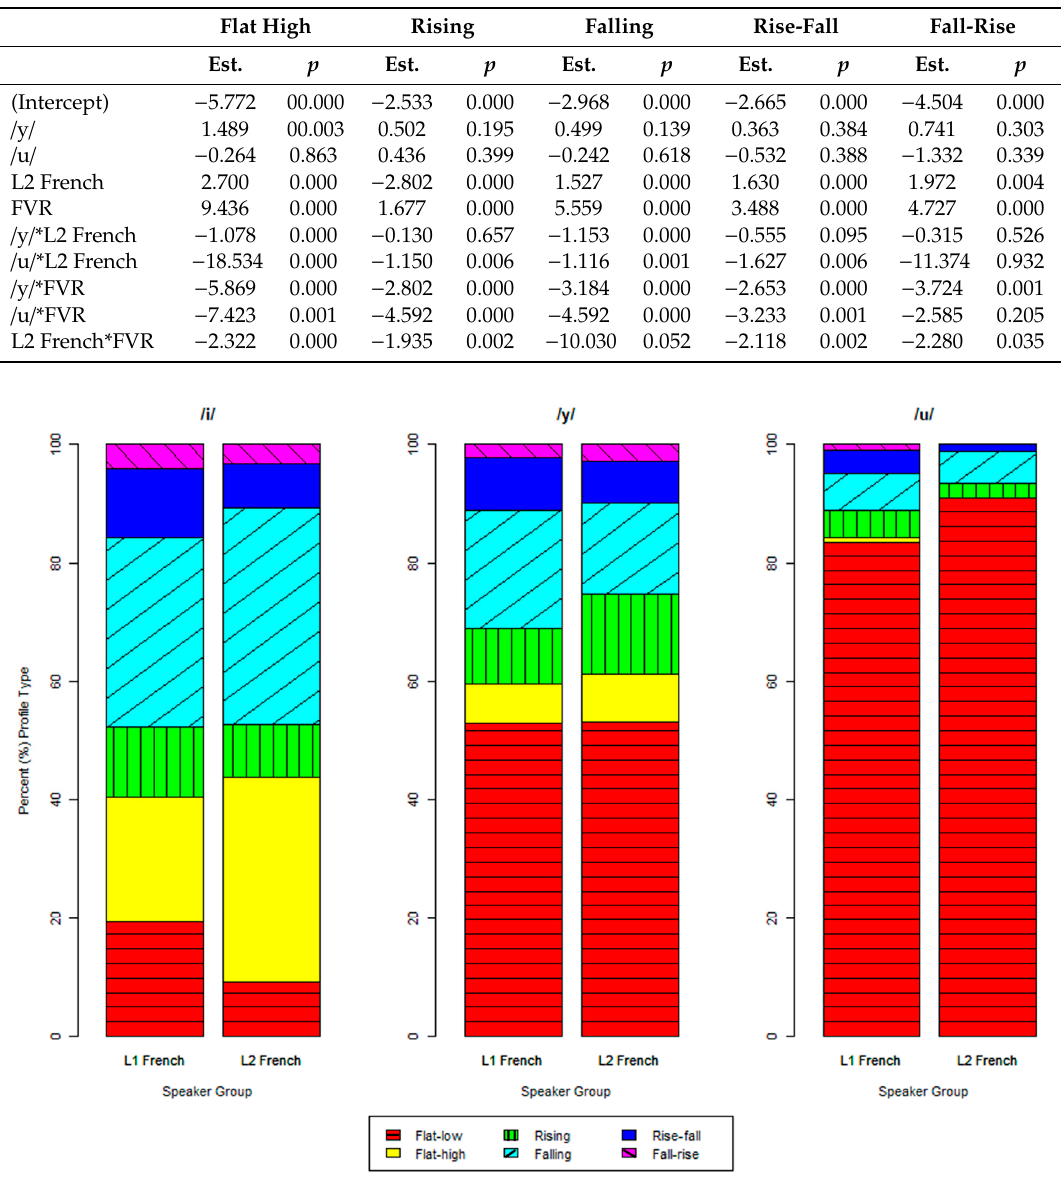
Table 9. Multinomial logistic regression model for profile.